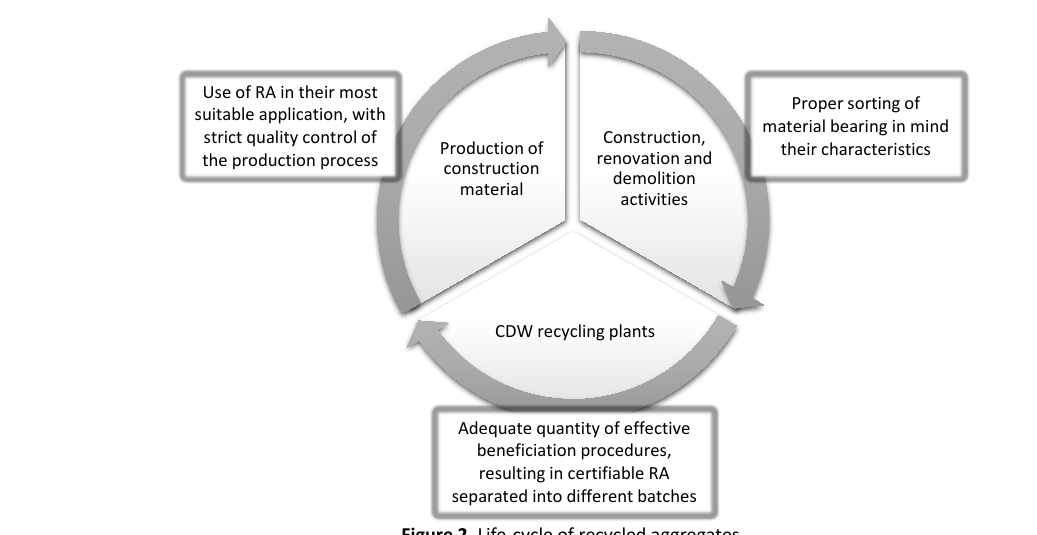
Figure 2. Life-cycle of recycled